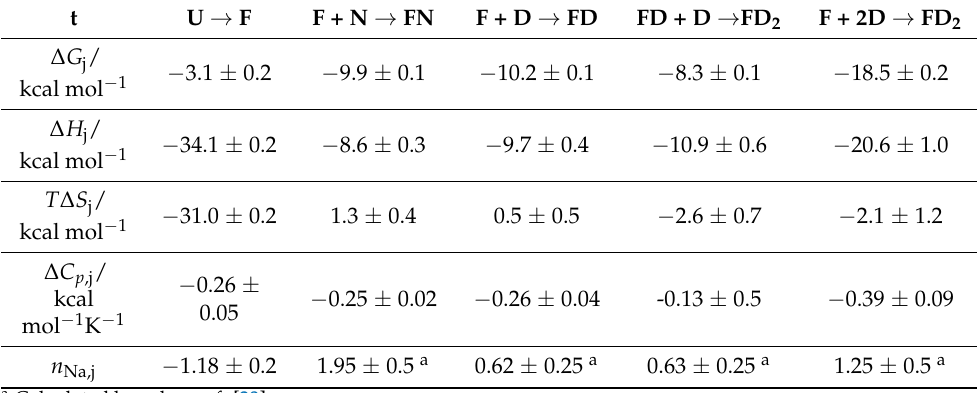
Figure 1. ITC isotherms accompanying netropsin (panel ( A )) and distamycin (panel ( B )) binding to the folded oligonu- cleotide. CD spectra of the oligonucleotide, netropsin (N), and distamycin (D) mixtures measured at 20 ◦ C (panel ( C )). UV-melting curves measured in the absence and in the presence of ligands (N or D). Symbols represent experimental data. Lines in panels ( A , B , D ) (absence of ligands) represent the corresponding best-fit model functions (Equations (1), (2), and (14)), while lines in panels ( C , D ) (presence of ligands) represent the calculated CD spectra (Equation (12)) and UV-melting curves (Equation (14)) using the best-fit parameters presented in Table 1. Table 1. Thermodynamic parameters characterizing the observed folding and binding steps (Scheme 1) at 20 ◦ C and 500 mM concentration of Na +